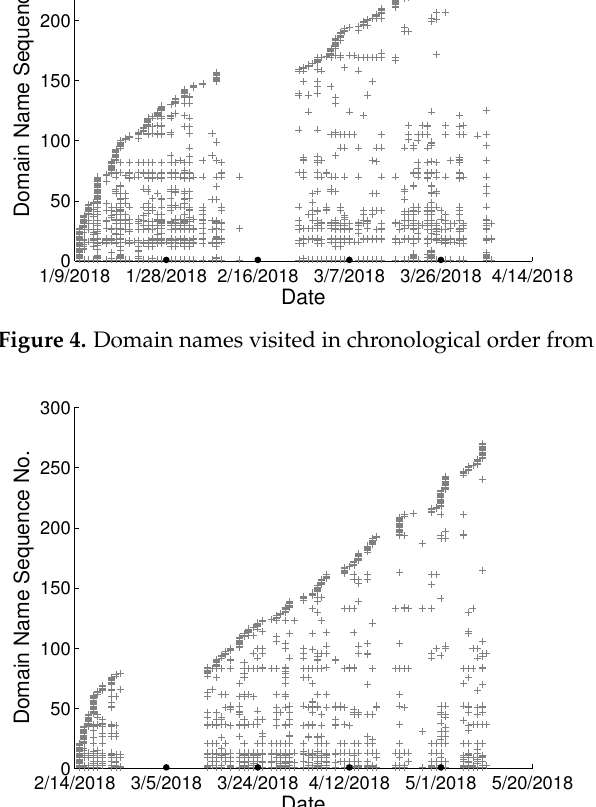
, k < t ≤ n and 1 × ( n − k )